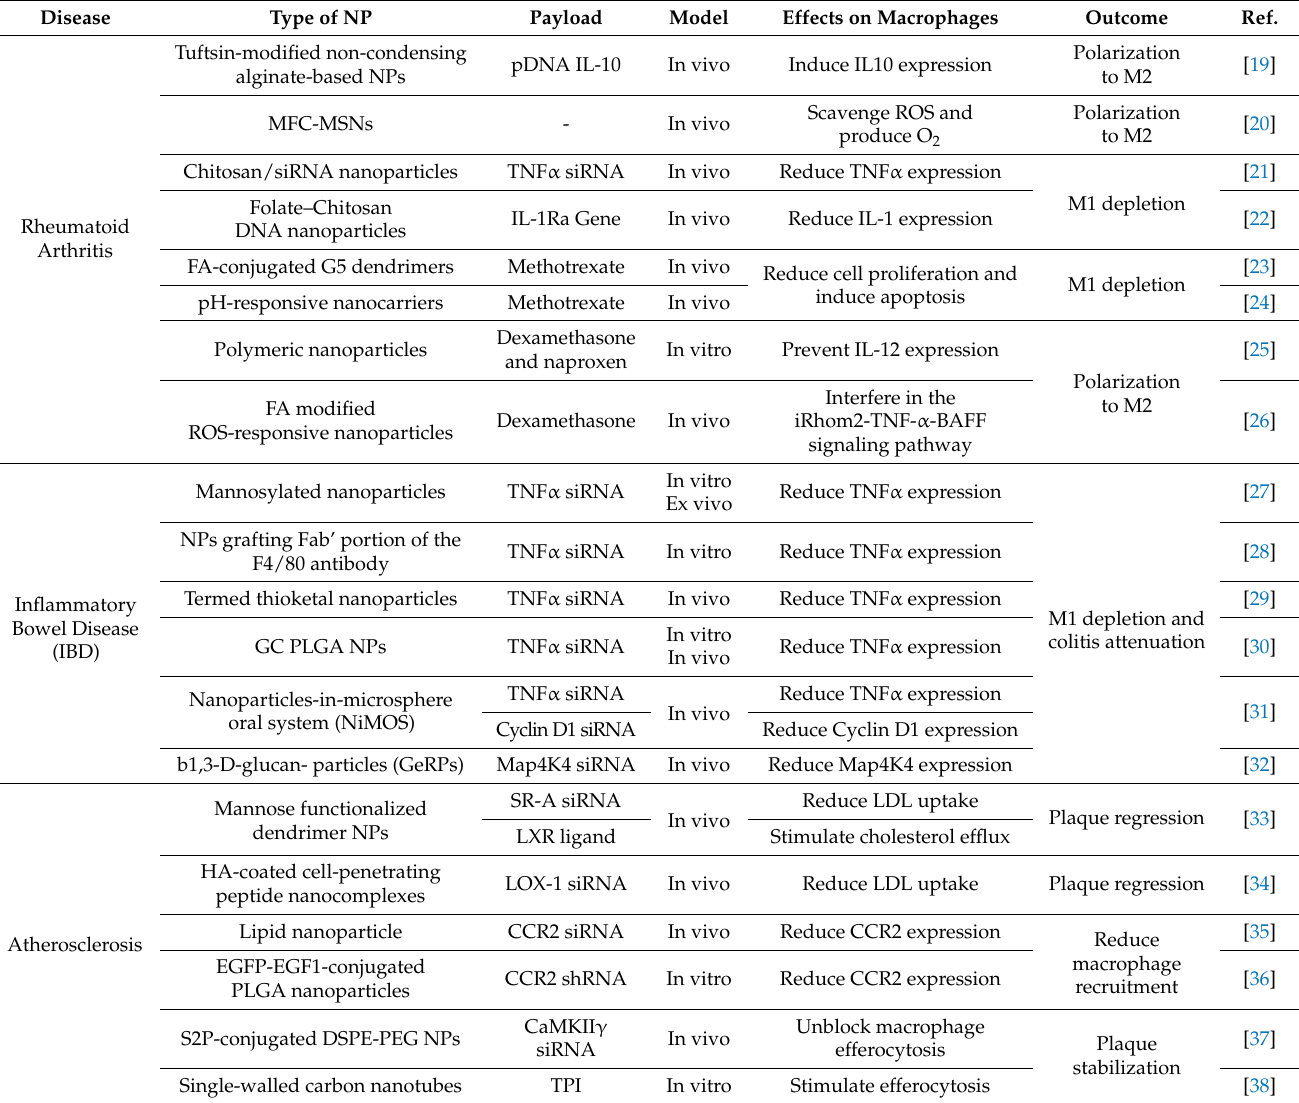
Table 1. Nanoparticle-based strategies to modulate macrophages in chronic inflammation. Disease Type of NP Payload Model Effects on Macrophages Outcome